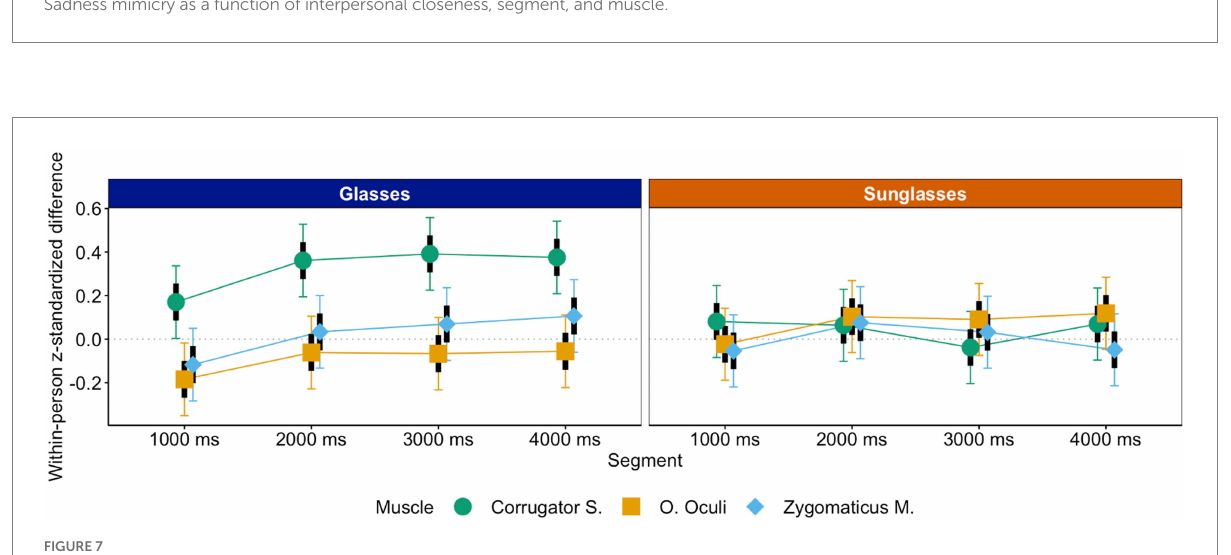
FIGURE 7 Anger mimicry as a function of eye contact, segment, and muscle.